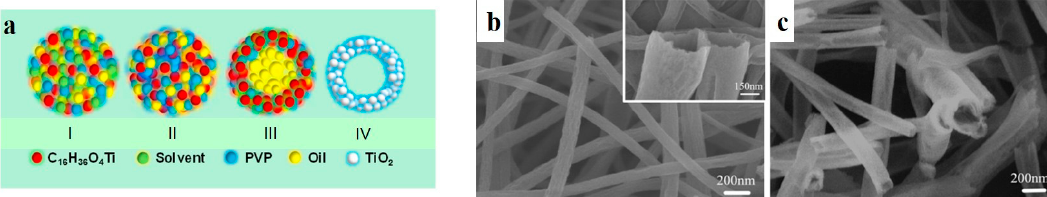
Figure 5. ( a ) The schematic illustrates the formation mechanism of TiO 2 nanotubes by emulsion electrospinning; SEM images of ( b ) neat TiO 2 nanotubes (the inset image verifies the